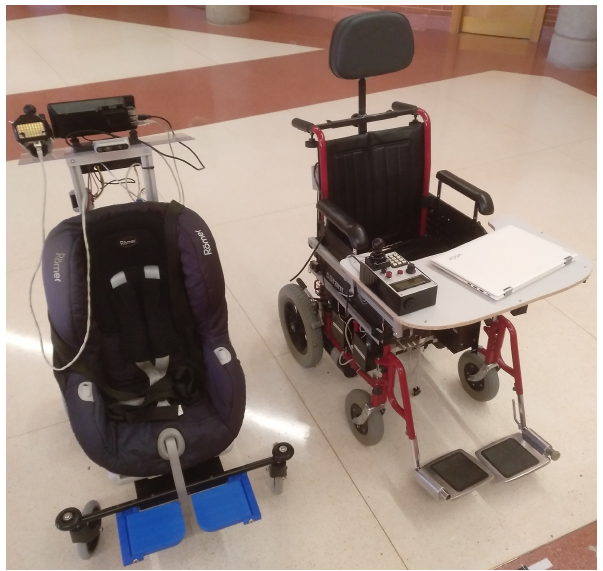
Figure 4. Picture of prototypes based on the proposed architecture: KATE ( left ) and SARA ( right